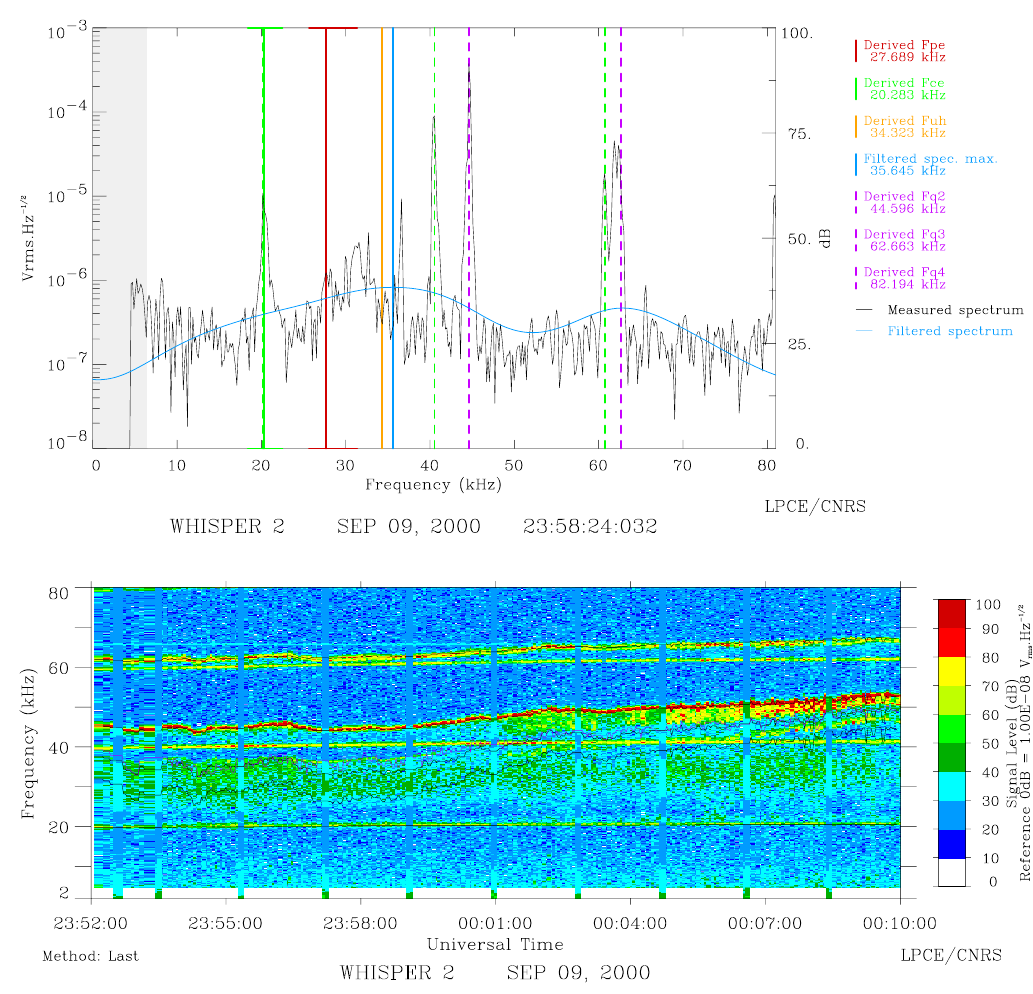
Fig. 5. Results of the resonance recognition process for a magnetospheric pass (bottom) and one of the individual spectra (top). See explanations in the text. Cluster-2 was on the dayside, at about 3 Earth radii close to the noon